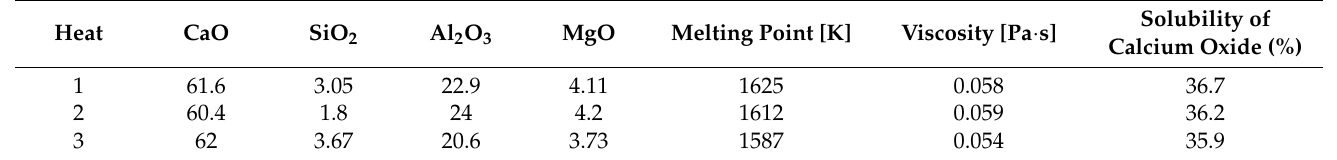
Table 4. The composition (wt%) and physical properties of the original refined final